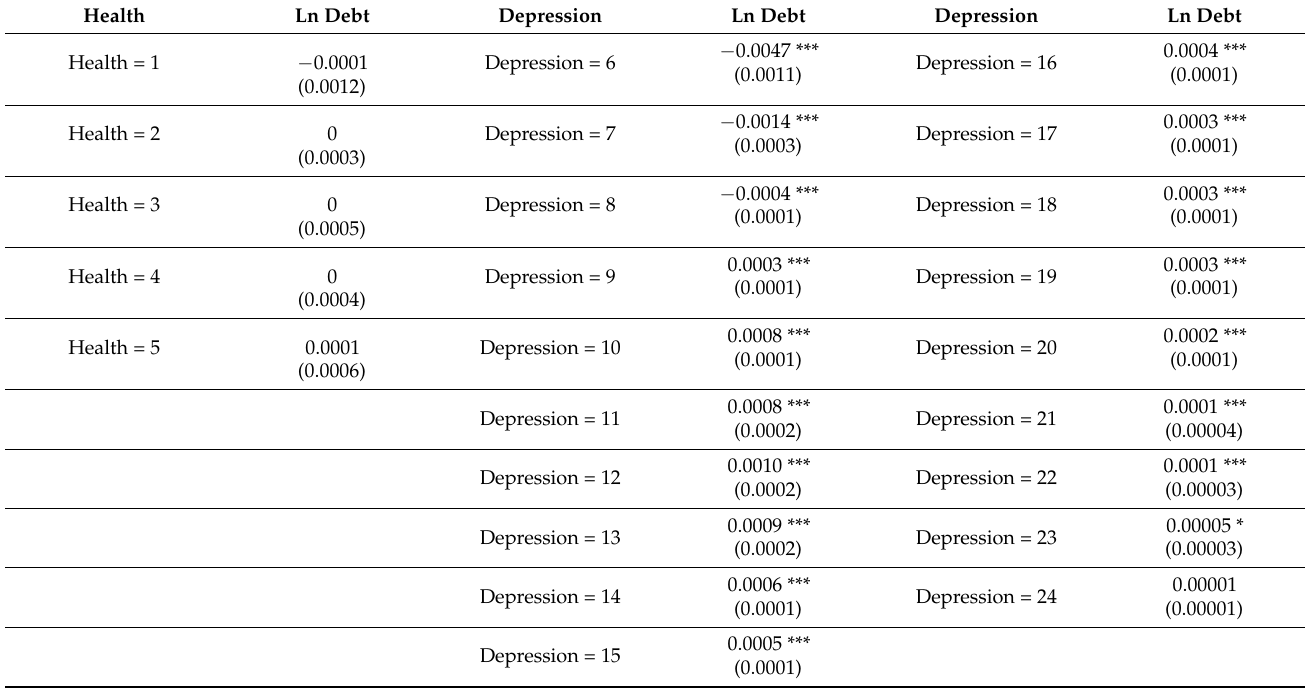
Table A2. Marginal effects of household debt in male